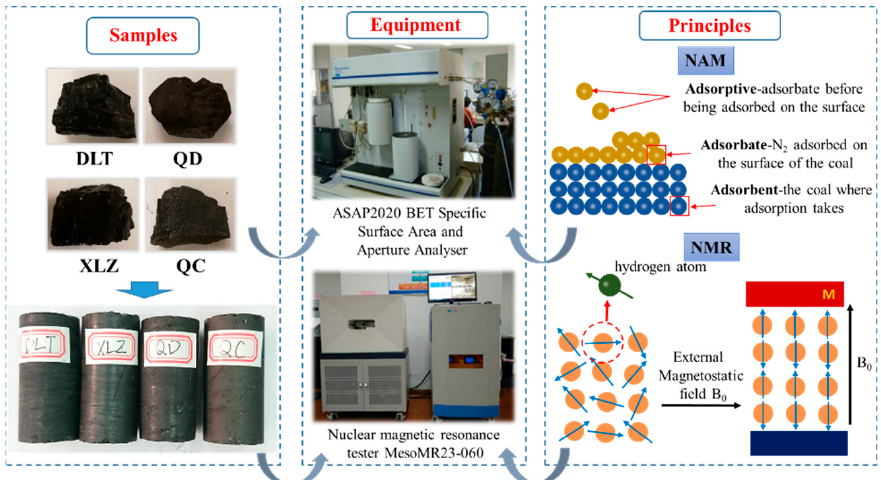
Figure 1. Experimental equipment and